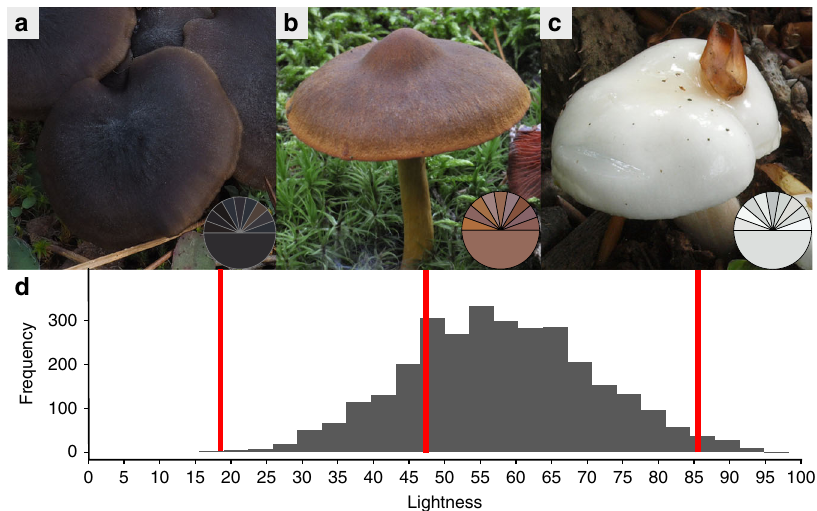
Fig. 2 Histogram of mushroom lightness. a – c Three exemplar species are shown with their respective color lightness (upper half of the pie chart represents each of the 9 single cap measurements; lower half of the pie chart the respective mean). Species from left to right: a Entoloma sericeum (color lightness: 18), b Cortinarius semisanguineus (color lightness: 47), c Hygrophorus eburneus (color lightness: 86). d Histogram of color lightness of 3054 mushroom- forming species (color range from 18 to 98). Photos by Peter Karasch ( a ) and Franz-S. Krah ( b , c ). Source data underlying d are provided in Supplementary Data 1, 2, and 3